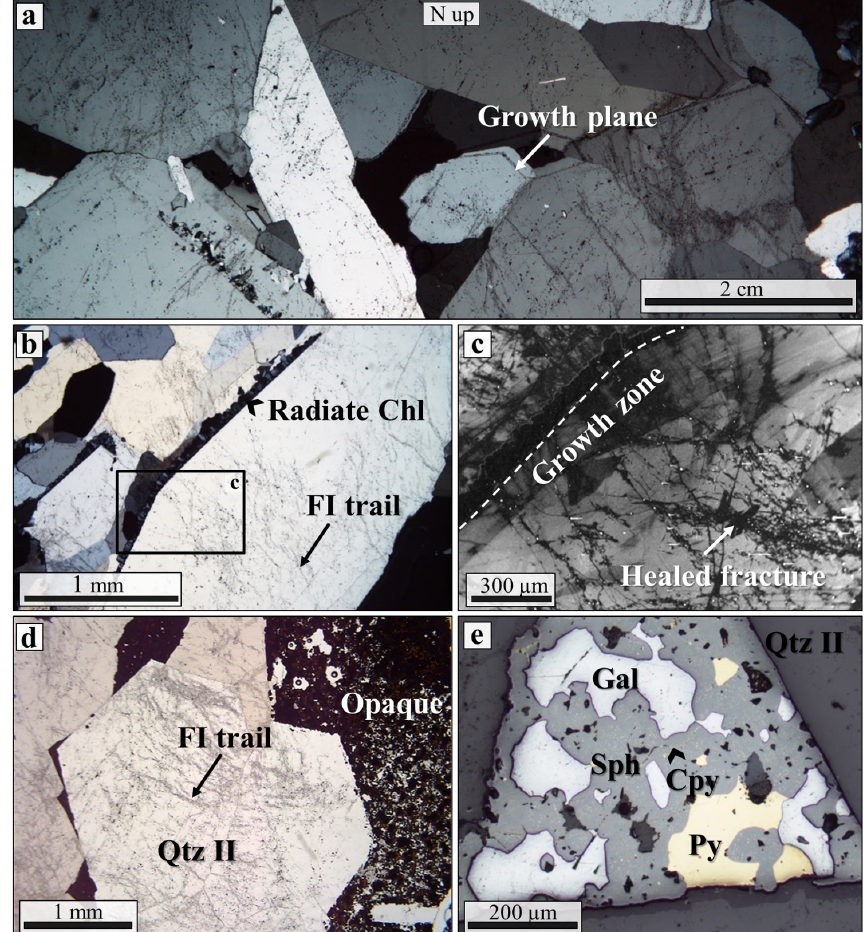
Figure 7. Microstructural characteristics of Qtz II from BFZ300 (samples TPH-120-6, PH22). (a) Stitched photomicrographs of Qtz II vein from the fault core. Notice the coarse quartz crystals and their elongated–blocky texture. Primary growth textures are sometimes visible and are marked by solid inclusions and decrepitated FIAs. (b) Radiate chlorite crystals along a prismatic Qtz II crystal boundary. Note that Qtz II is cross-cut by numerous trails of FIs. (c) Panchromatic cathodoluminescence image of the same large Qtz II crystal from panel (b) , showing radiate chlorite along the crystal boundary and a primary growth zone cut by a set of healed fractures. (d) Euhedral quartz crystals set within opaque phases and cross-cut by a network of thin microfractures. (e) Reflected-light photomicrograph showing the opaque mineral assemblage typically associated with Qtz II, i.e. subhedral to anhedral sphalerite, pyrite, and galena. Chalcopyrite is a minor phase and occurs as small round inclusions within sphalerite (chalcopyrite “disease”) or as large subhedral–anhedral masses together with